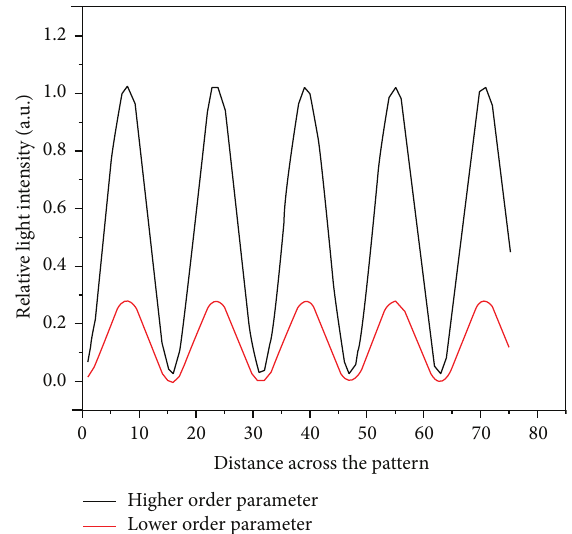
Figure 11: Decrease of light intensity (and contrast) across finger- print structure at decreased order parameter 𝑆